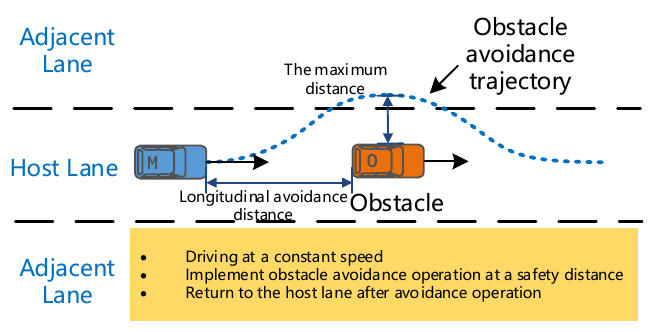
Figure 8. Schematic diagram of the obstacle avoidance experiment.